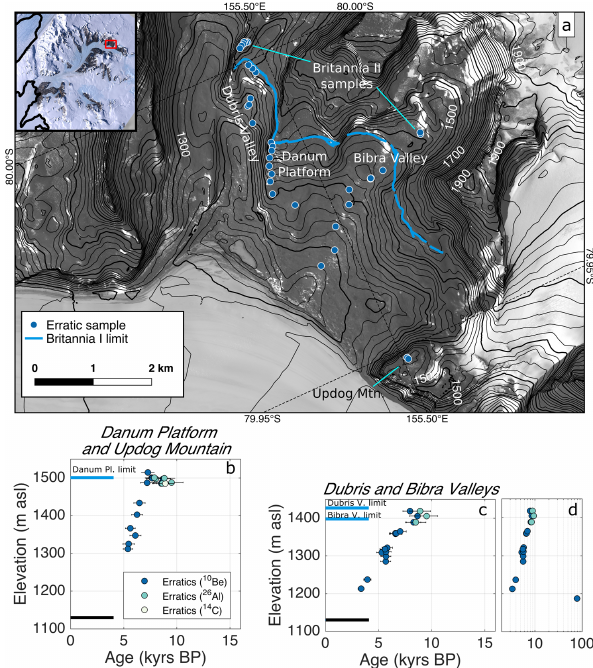
Figure 2. (a) Simplified map of Dubris and Bibra valleys, show- ing sample locations and elevations shown in 20m contours (100m contours are in bold). The blue curve represents the Britannia I limit; erratic samples outboard of that limit are taken from the limit of the older Britannia II deposit. Britannia II ages are not presented in this paper but are archived at http://ice-d.org (last access: 3 May 2021). Contours and satellite imagery from LINZ (2010), sourced from NZTopo Database, Crown Copyright Re- served. This product (LINZ Darwin Glacier orthophotos) incor- porates data which are © Japan Aerospace Exploration Agency (“JAXA”) 2008. Inset imagery from Bindschadler et al. (2008). (b, c) Mean surface exposure ages with total uncertainty at 1 standard deviation for glacially transported cobbles and boulders from atop bedrock platforms and valley floors, showing a stable margin until 7–8ka, after which the glacier thinned steadily towards its modern configuration. The horizontal black line shows the elevation of the present-day glacier margin; horizontal blue lines show approximate elevations of the Britannia I limit at each location. (d) All surface exposure ages of the Britannia I deposit in Dubris and Bibra valleys are on a logarithmic scale to include one sample with significant inherited